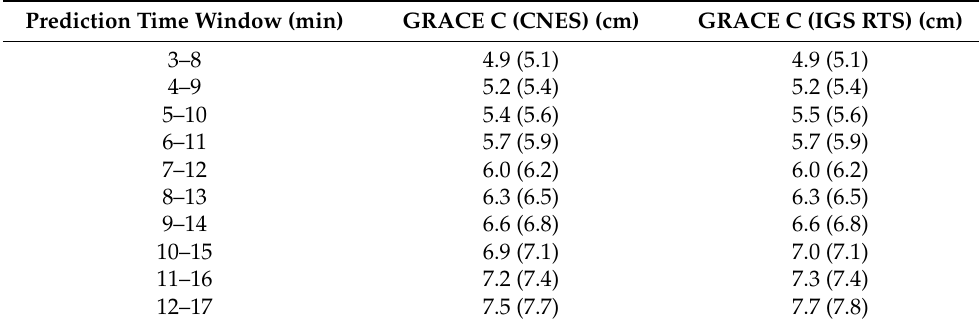
Table 9. Averaged OURE of the predicted orbits of GRACE C with less healthy data and reduced height from 6 to 12 August 2022. The results without outlier exclusions are given in